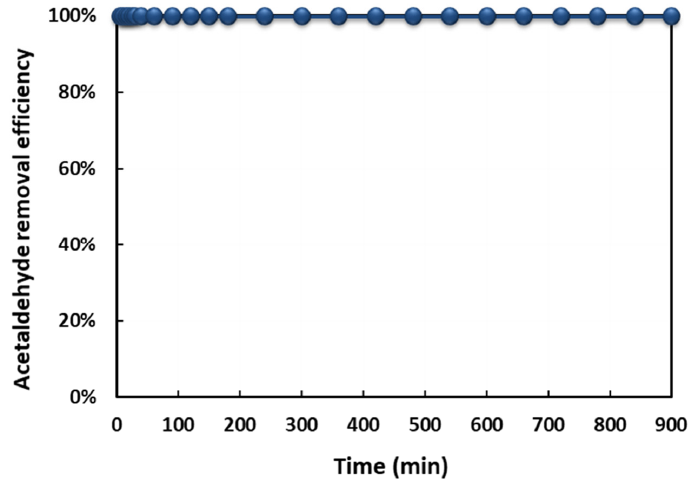
Figure 7. The long-term catalyst stability test for the acetaldehyde oxidation. Relative Humidity: 60%, The amount of catalysts: 5 g.